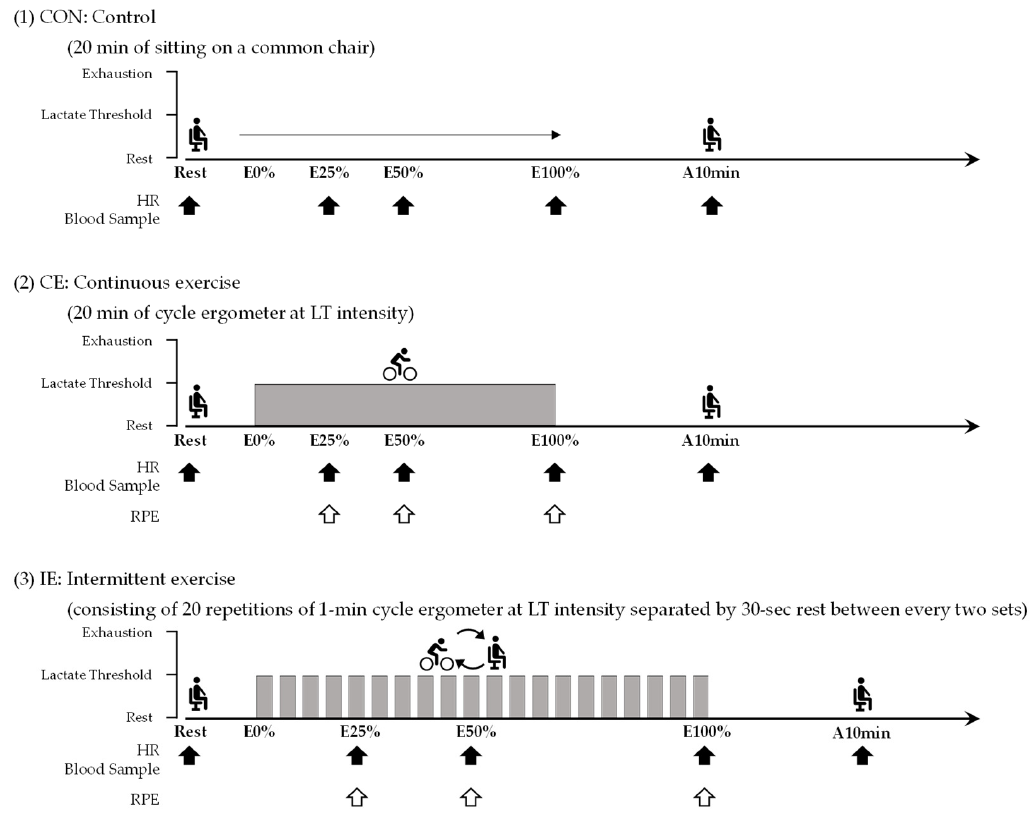
Figure 1. Experimental design: The control (CON) comprised a 20-min period of sitting on a standard chair, continuous exercise (CE) was performed as a 20-min bout of cycling on the cycle ergometer at lactate threshold (LT) intensity, and intermittent exercise (IE) was performed as 20 sets of a one-min bout of cycle ergometer exercise at LT intensity with a 30-s rest between every two sets. HR: heart rate, RPE: Borg rating of perceived exertion. HR measurement and blood sampling were performed 10 min before the onset of cycling (Rest), at the 25%, 50%, and 100% time points of exercise (E25%, E50%, and E100%), and at 10 min after running (A10min), while RPE was at E25%, E50%, and E100%. The closed arrow ( ) and open arrow ( ) indicate the timing of HR measurement and blood sampling and the timing of RPE measurement, respectively.